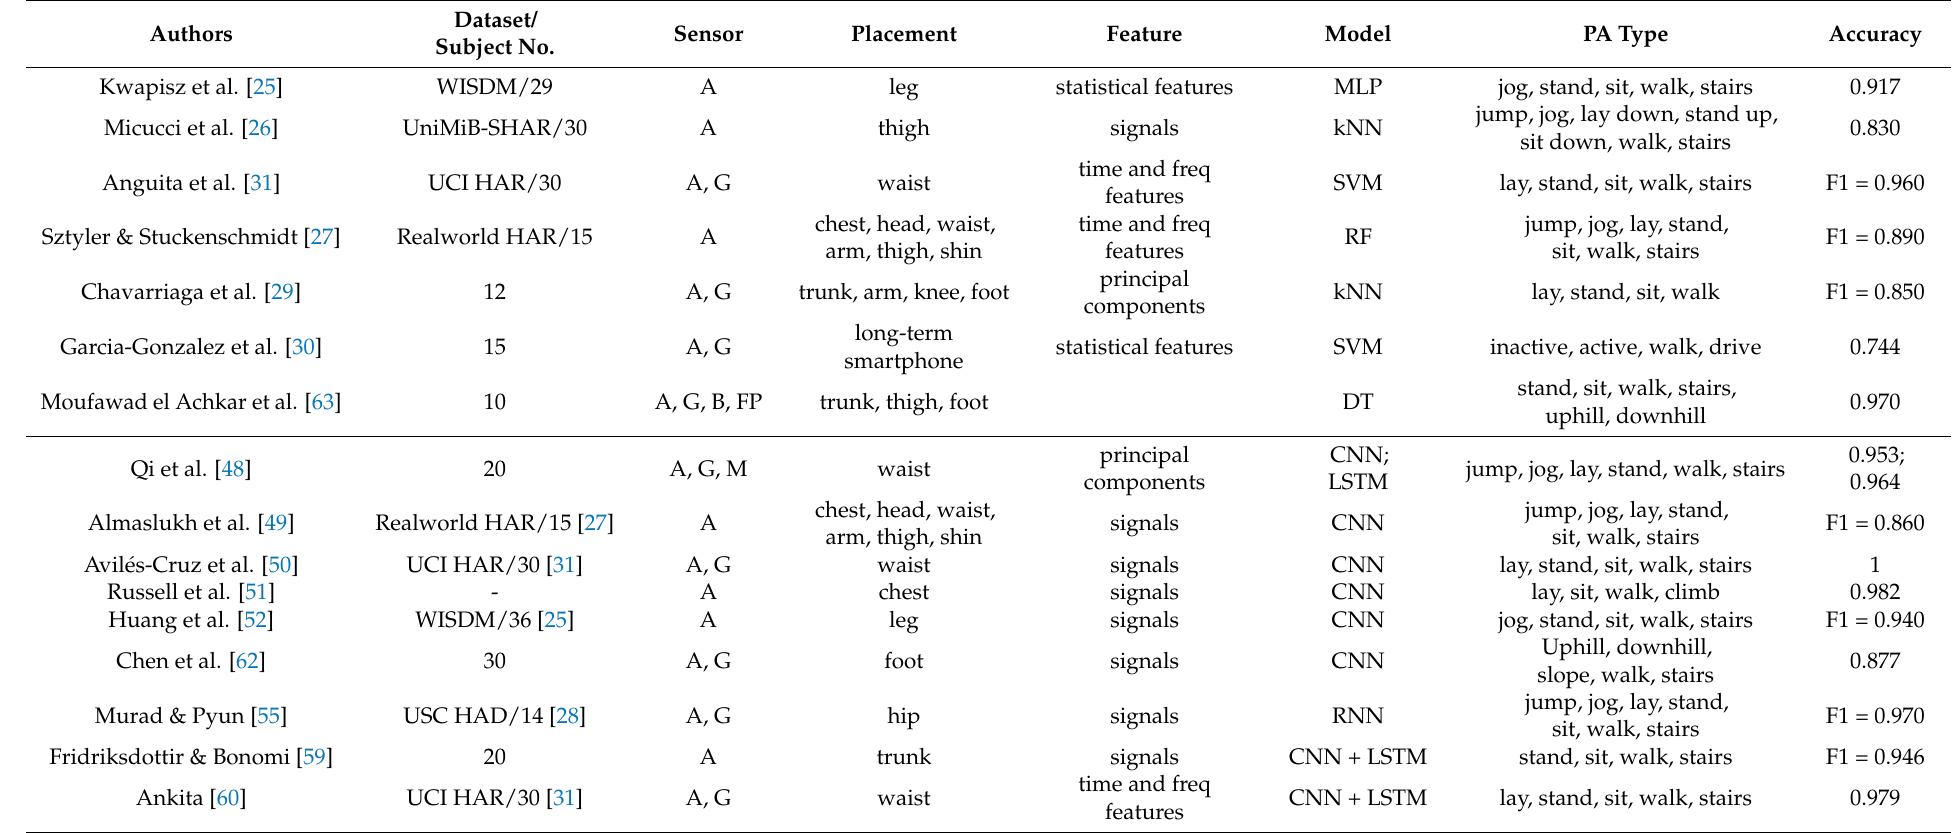
Table 1. Methods for physical activity (PA)